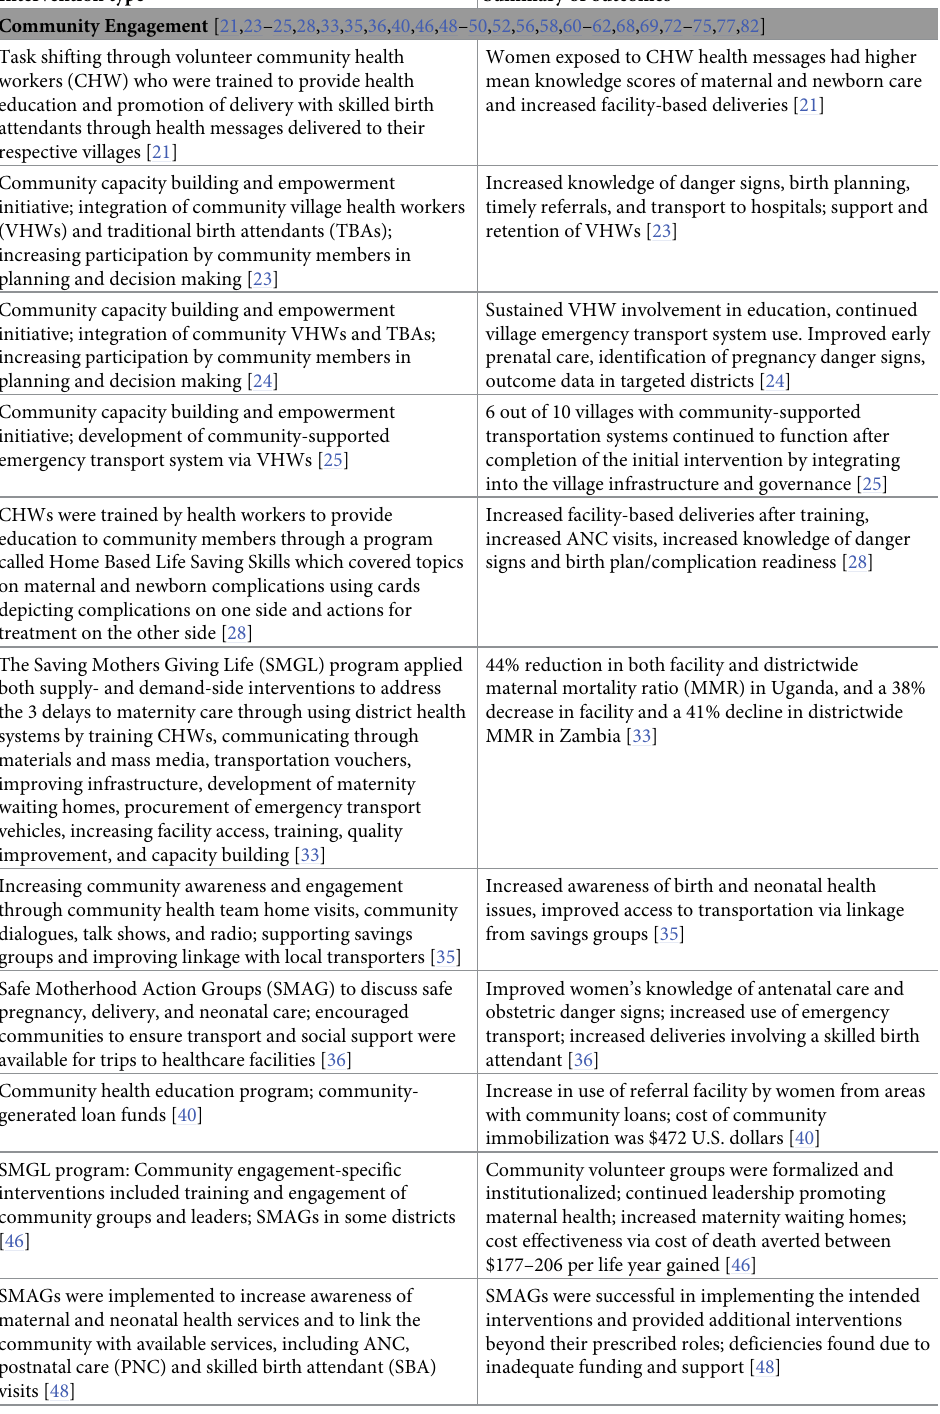
Table 2. Summary of intervention descriptions and outcomes, grouped by